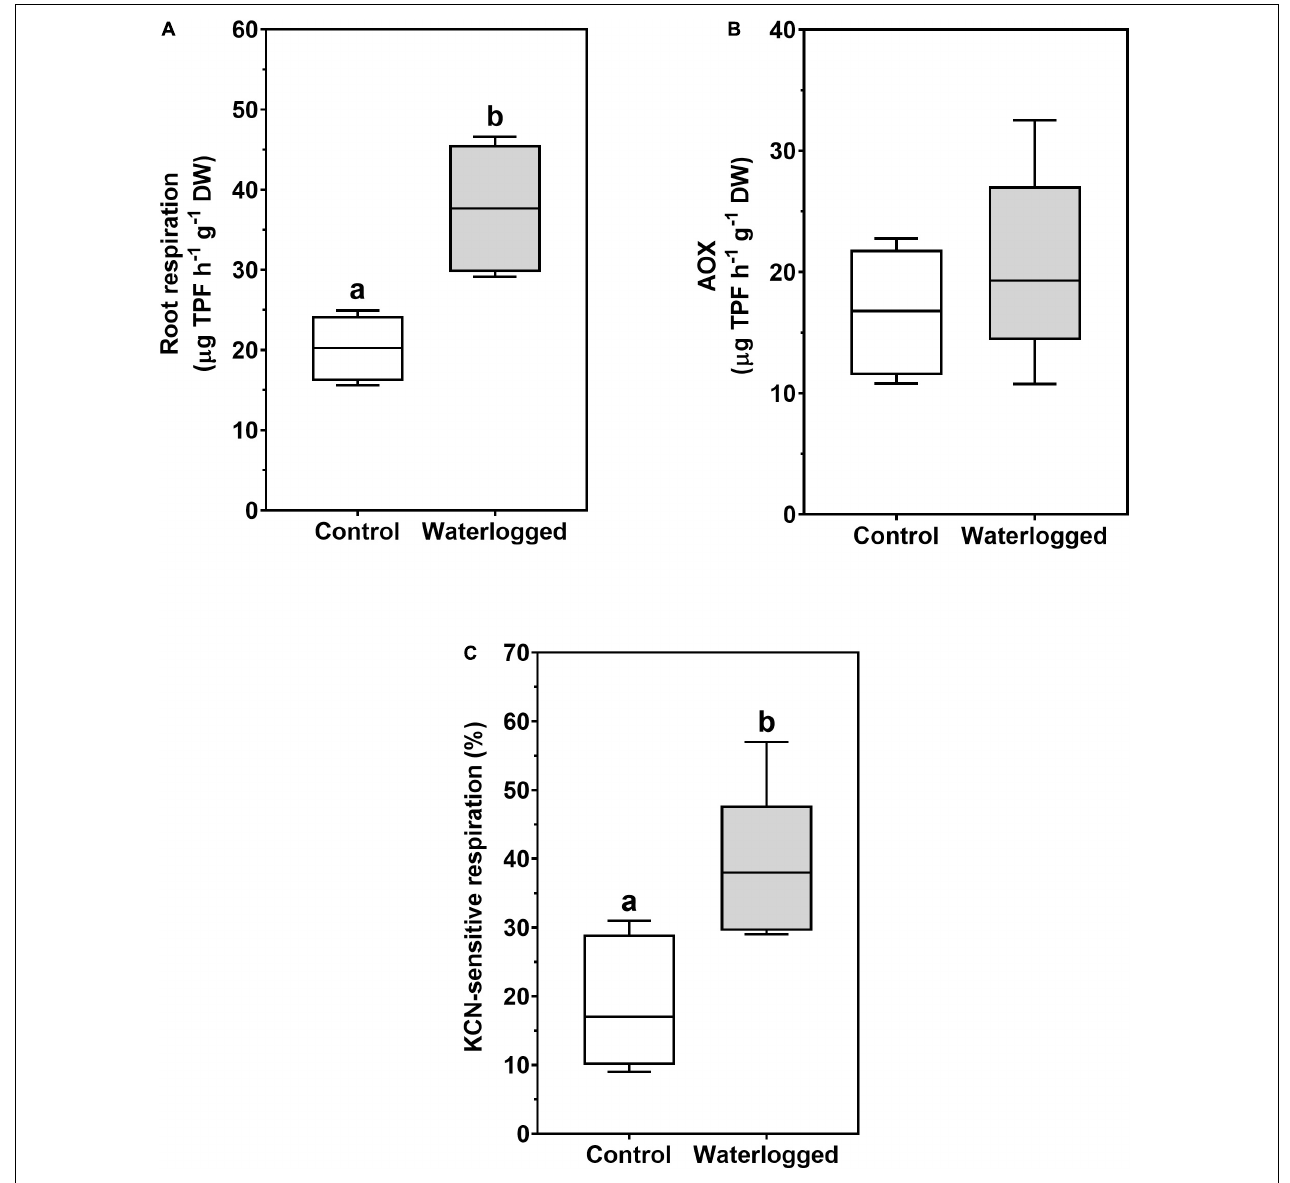
FIGURE 8 | Boxplots of root respiration (A) , alternative oxidase (AOX) activity (B) , and percentage of KCN-sensitive respiration (C) in roots of control plants (white boxes) and waterlogged plants (gray boxes) of Spartina patens after 30 days ( n = 5, different letters indicate significant differences at p < 0.05).